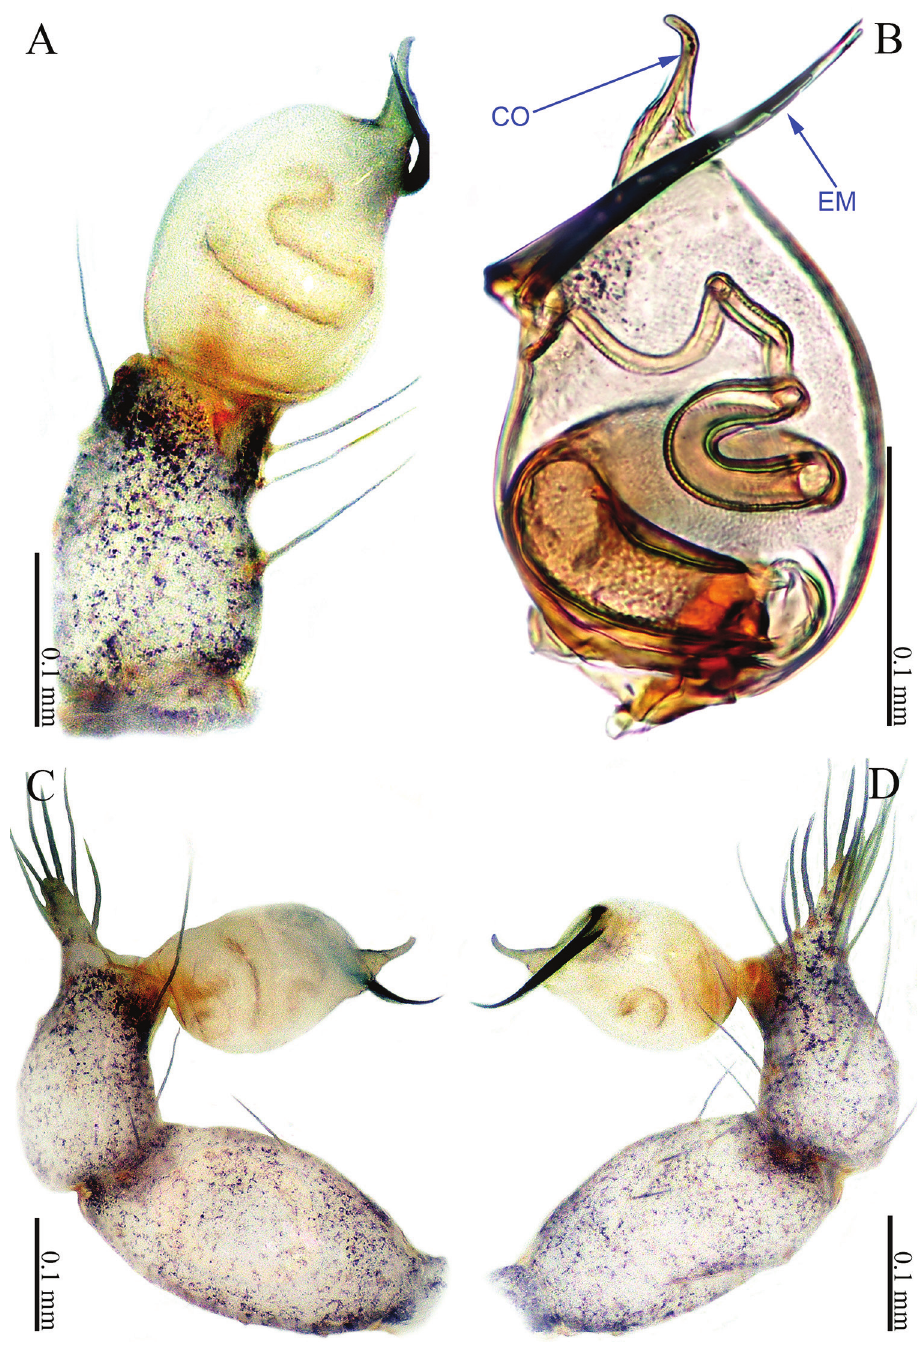
Figure 15. Sinoderces aiensis Li & Li, sp. nov., male holotype A palp, ventral view B palp, prolateral view C palp, retrolateral view D palpal bulb, ventral view. Abbreviations: CO conductor, EM